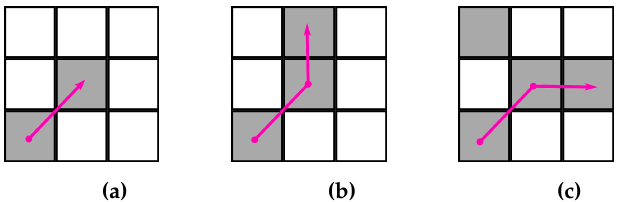
Figure 4. Example neighborhoods/detection steps. The magenta lines symbolize detected polyline objects. ( a ) Line start; ( b ) Direction change; ( c )